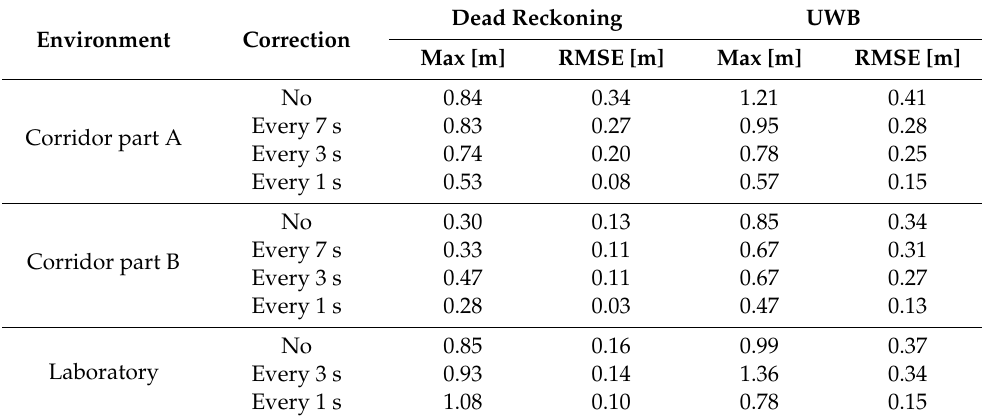
Table 3. The displacement errors using di ff erent methods without and with regular correction.